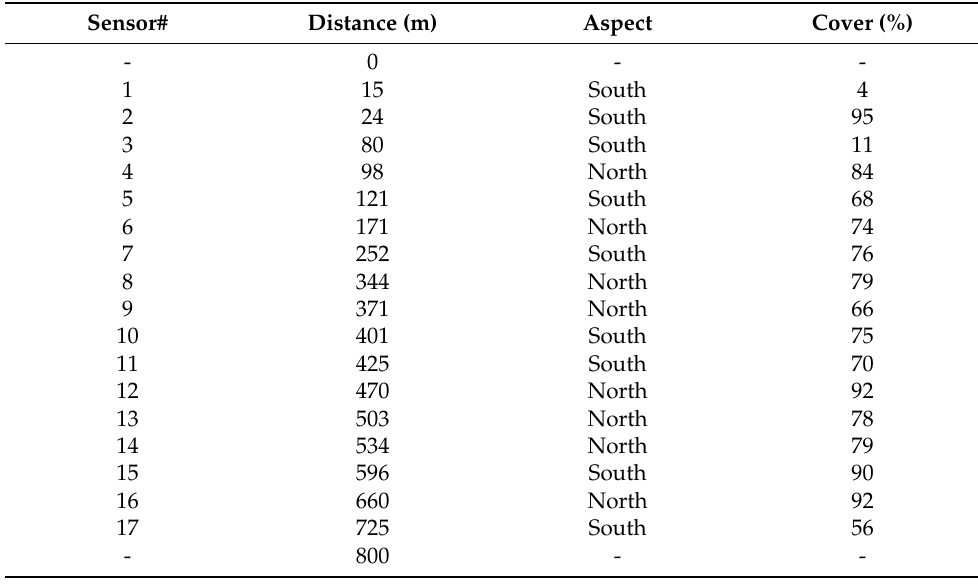
Table A1. Distance from the beginning of the reach, aspect, and riparian vegetation cover above each stream temperature